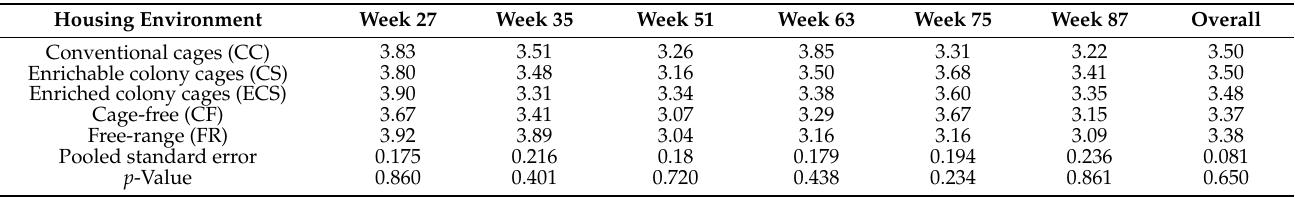
Table 11. The effect of housing environment on vitelline membrane elasticity (mm) of brown egg layers by week and